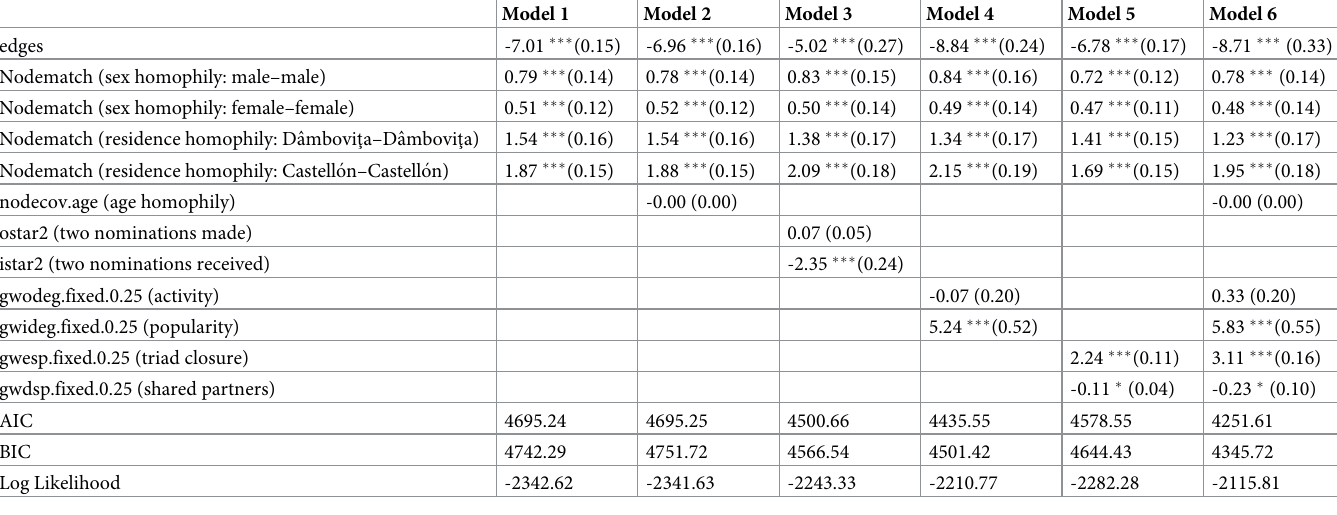
Table 6. Micro-level determinants of nomination tie patterns, in the link-tracing network of study